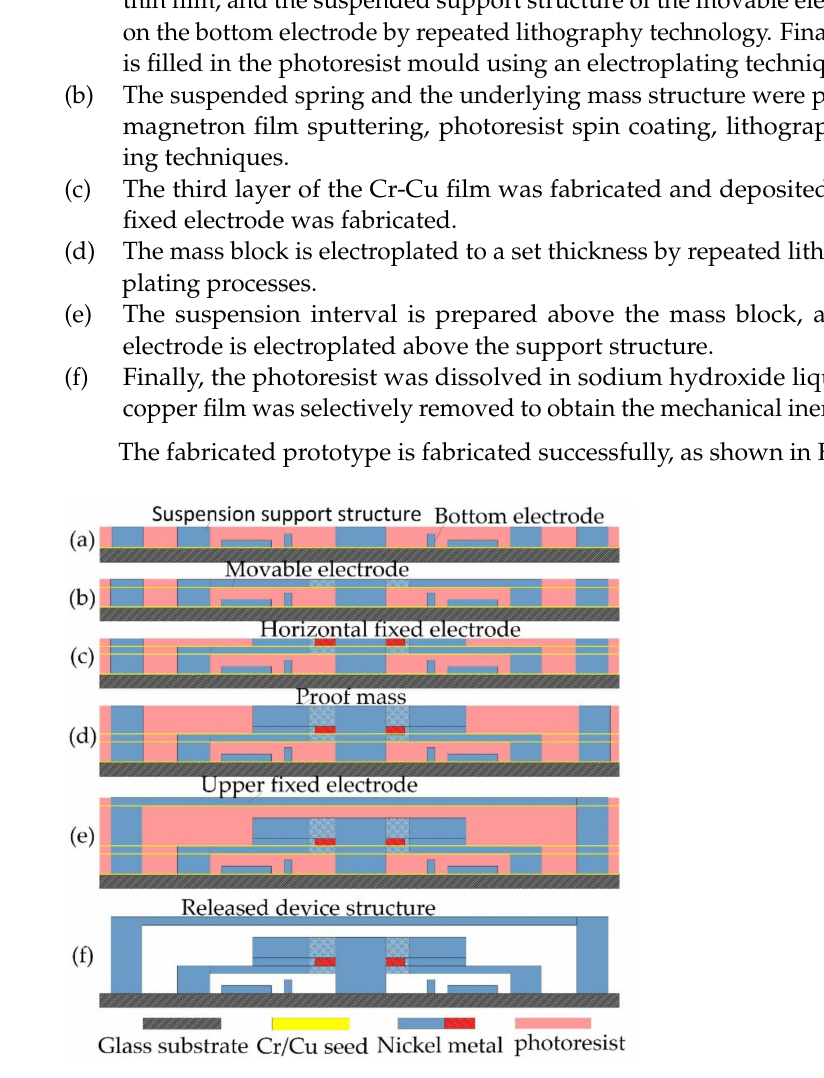
Figure 6. The diagram of fabrication. The prototype is packaged and tested by the dropping hammer system, as shown in Figure 8. The prototype is fixed on the fixture fabricated by 3D printing technology. The fixture is composed of two parts: a base plate fixed on a vibrating platform and a rotating circular objective table. The prototype is fixed on the objective table. The sensing direction of the device is perpendicular to the vibration plane. When the acceleration reaches the threshold value of the testing device, the inertial switch will be switched on trigger signal curves output to an